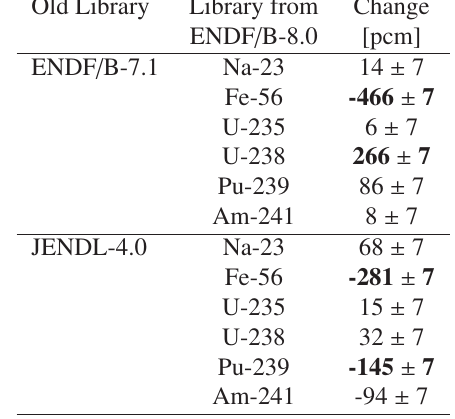
In Fig. 2, the radial layout of the oxide core is shown.